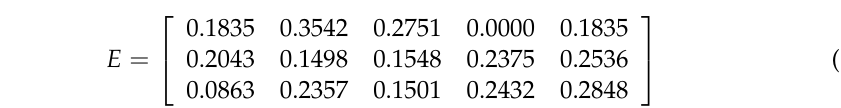
Table 5. Experimental use of SAR image data details.